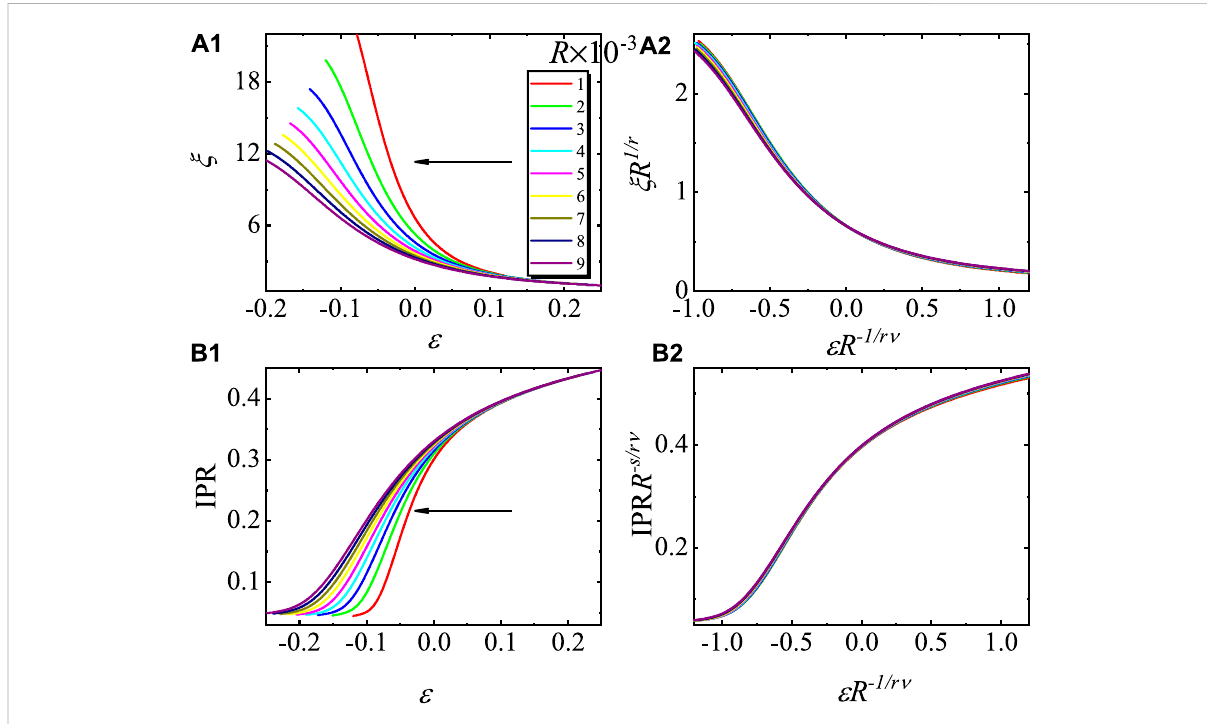
FIGURE 7 Drivendynamicswiththeinitial609thexcitedstateat ε =1.(A1)Curvesof ξ versus ε ,and(A2)therescaledcurvesaccordingtoEq.10fordifferent R values. (B1) Curves of the IPR n versus ε and (B2) the rescaled curves according to Eq. 11 for different R values. Here, we use ε 0 = 1, g = 0.5, and L = 987, and the results are averaged for 10 choices of ϕ . The arrows in (A1) and (B1) point to the direction of the changing ε